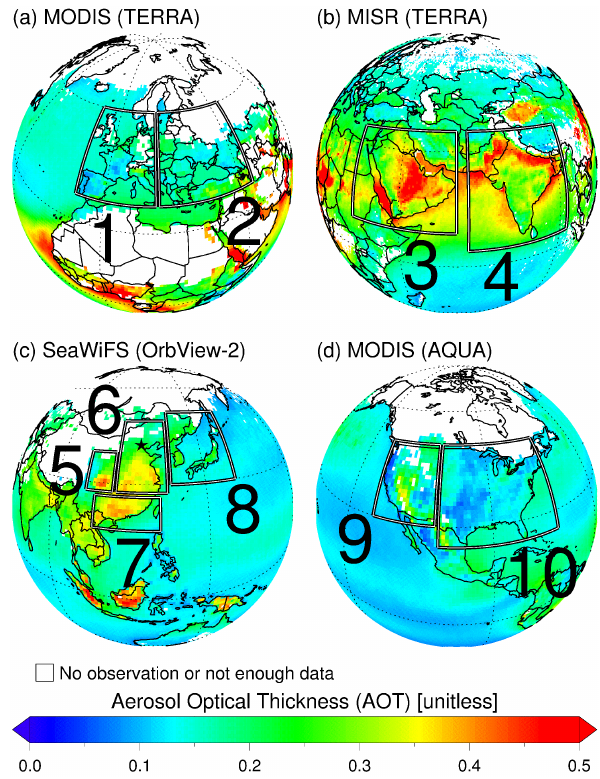
Figure 1. Plots of the mean values of (a) MODIS (Terra) AOT (550nm) from March 2001 to December 2009, (b) MISR (Terra) AOT (558nm) from March 2001 to December 2010, (c) SeaWiFS (OrbView-2) AOT (510nm) from January 1998 to December 2007, and (d) MODIS (Aqua) AOT (550nm) from January 2003 to De- cember 2008 for the selected regions (1) western Europe, (2) east- ern Europe, (3) the Middle/Near East, (4) southern Asia, (5) central China, (6) eastern China, (7) southern China, (8) Korea/Japan, (9) western USA, and (10) eastern USA. The black star in region 6 is the location of the AERONET station in Beijing. “No observation or not enough data” represents the discarded data series, which consist of less than seven monthly data points for a single